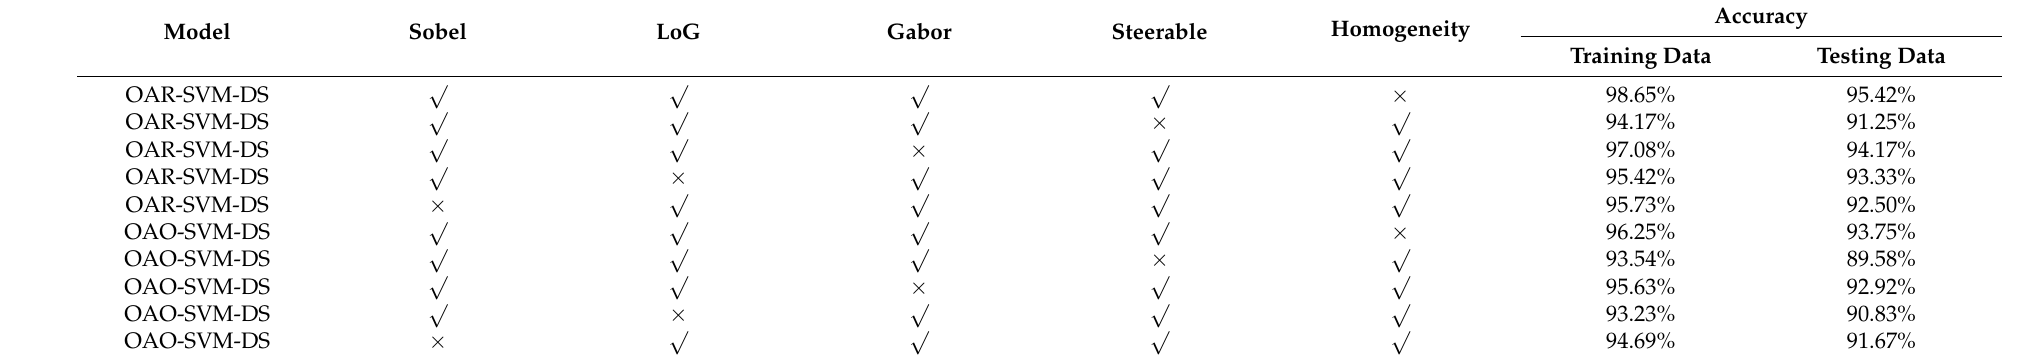
Table 23. Result of ablation study of the proposed method with different combinations of filtering